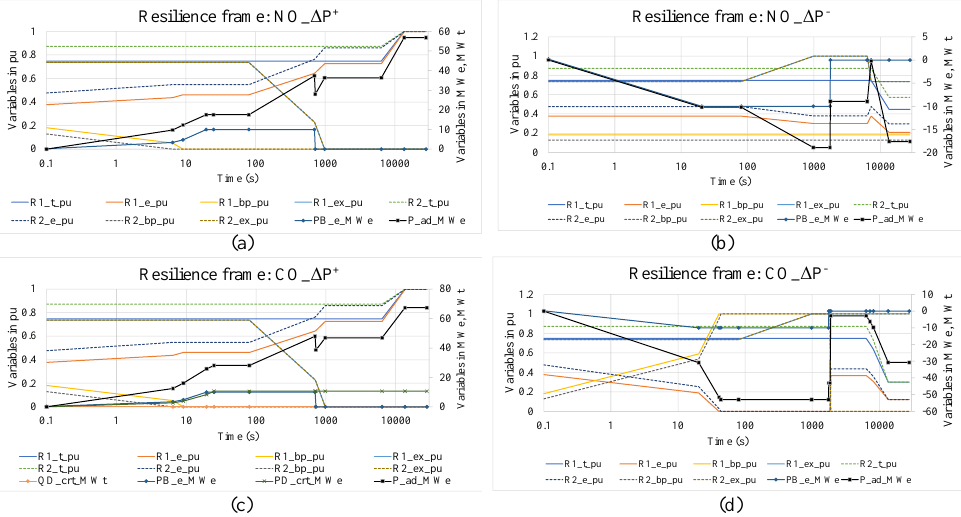
Figure 13. Resilience frames for ∆ P + and ∆ P − in NO and CO at 300.97769 h: ( a ) NO_ ∆ P + ; ( b ) NO_ ∆ P − ; ( c ) CO_ ∆ P + ; ( d ) CO_ ∆ P − . Figure 14 maps the adaptive capacity curve to the DIRE curve for the first case of 0 h to analyze the Rs of resilience (i.e., resist, response, and recover). Although all assets are represented in terms of their capacity to respond to disturbances, they have differ- ent principal functions. BES, for example, is operated immediately and helps to arrest disturbance and resist the dynamic performance degradation. Therefore, a part of the BES response will fall under the resist epoch which is considered in the first 10 s of the resilience frame for the purpose of this paper. It is the time when a disturbance typically grows. The steam extraction system operates to maintain generation–demand balance for steady-state operation. It falls mainly during the response epoch between 10–1000 s during which disturbance reaches its peak and persists. The reactor power control with CLS falls under recover epoch (>1000 s), and it helps recover steam extraction setpoint and energy lost of energy-limited assets while responding to the disturbance.